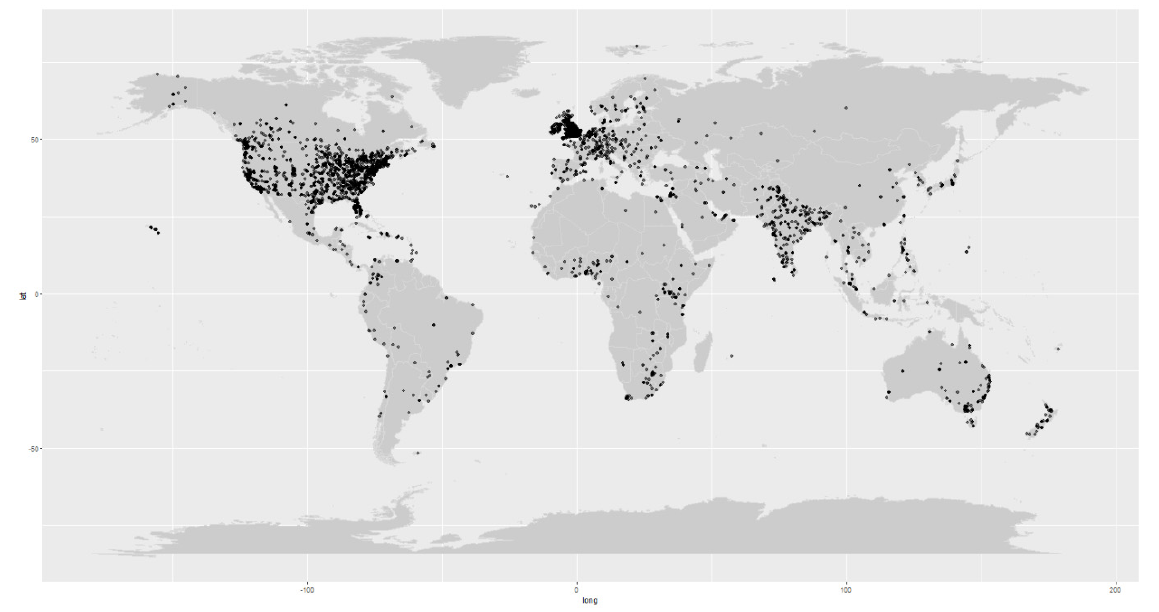
Figure 2. Geographical locations of the tweets included in this study. Each tweet is indicated by a black dot in the map.